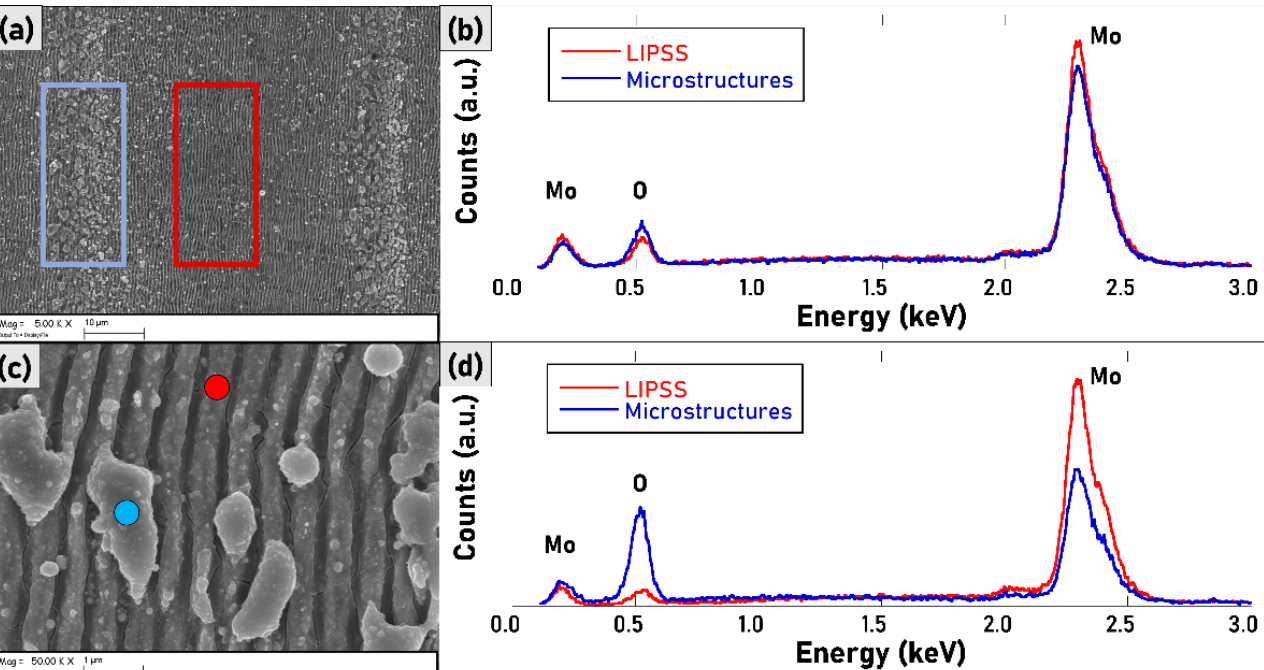
Figure 3. ( a ) SEM micrograph (magnification 5k×) of sample S2. The large-area regions indicated with red and blue boxes were characterized with EDX. ( b ) EDX spectra of the regions highlighted in Figure 3a. ( c ) SEM micrograph (magnification 50k×) of sample S2. The local points indicated with red and blue circles were characterized with EDX. ( d ) EDX spectra of the regions highlighted in Figure 3c.